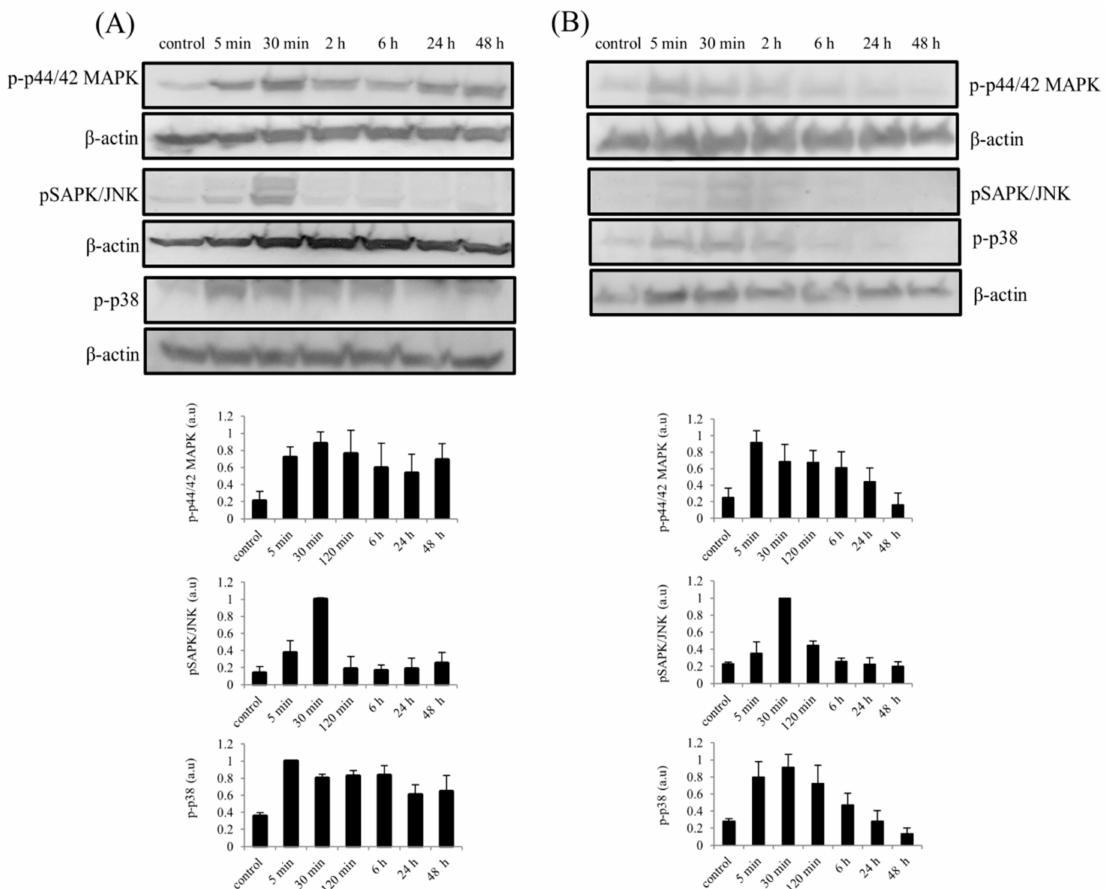
Figure 6. Activation of MAPK cascade proteins in ( A ) hTCEpi cells and ( B ) SFs after treatment with BMP7 (100 ng/mL) at different time points. Cells were treated with BMP7 and the total cell lysates were collected at time points 5 min, 30 min, 2, 6, 24 and 48 h after stimulation, and subjected to immunoblot analysis. Sustained activation of p44/42 MAPK and p38 until 48 h in hTCEpi cells and until 6 h in SFs was observed, whereas, in both cell types, only transient activation of pSAPK/JNK was observed. Amounts of the β -actin protein levels which were detected with an anti- β -actin antibody served as a loading control. Differences in the phosphorylation levels (p44/42 MAPK, SAPK/JNK and p38) were quantified using ImageJ software and the values were normalized to the corresponding β -actin signal. Data represent mean ± standard deviation of the phosphorylation levels shown as arbitrary units from more than three independent experiments. One representative immunoblot of at least three independent experiments is